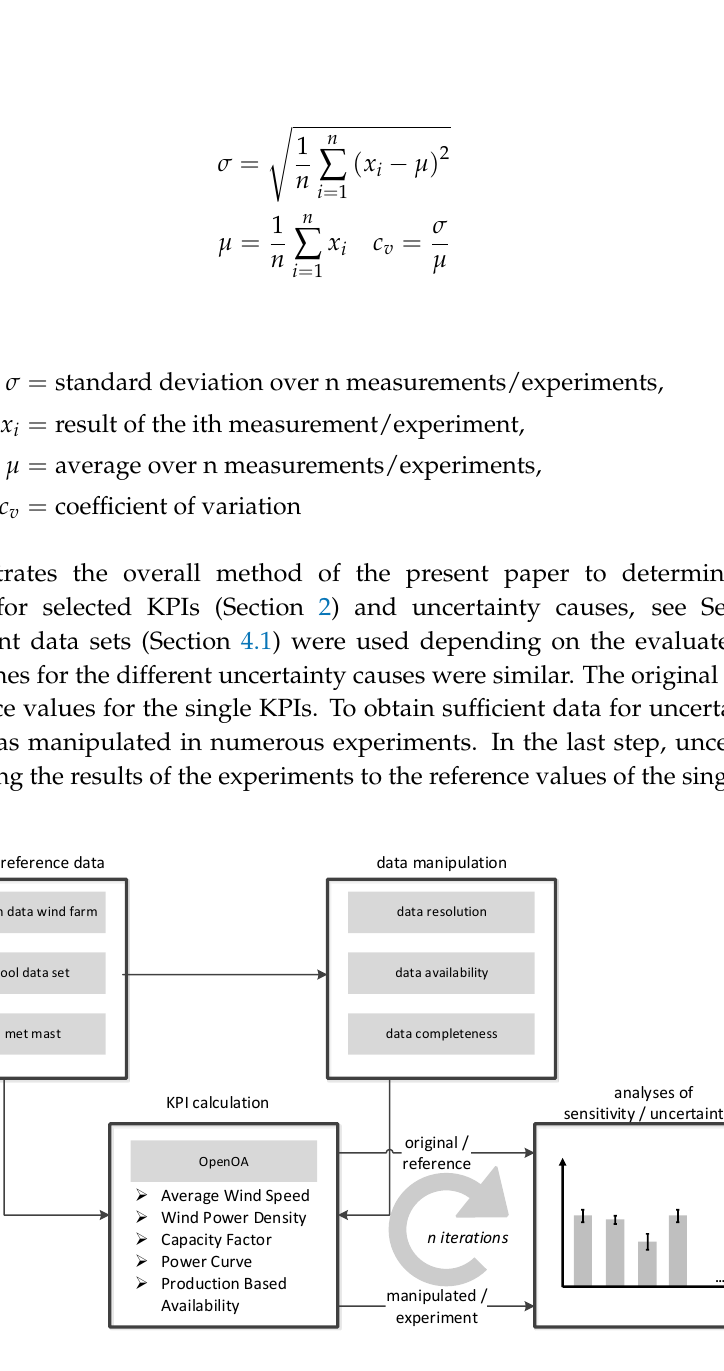
Figure 2. Approach of this paper to analyze sensitivities and uncertainties for selected KPIs and uncertainty